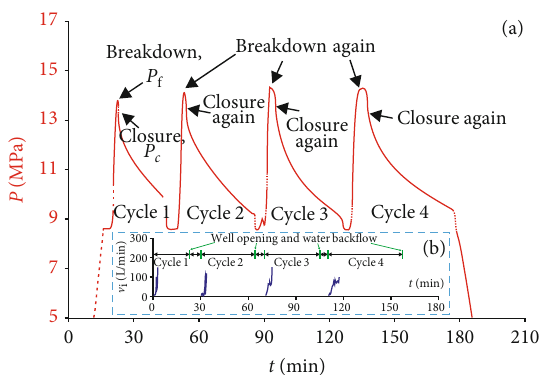
Figure 3: In situ stress measurement curve of an actual CBM well: (a) relationship between pressure and time; (b) relationship between the injection rate and time at the surface: P f represents the fracturing pressure and P c represents the closing